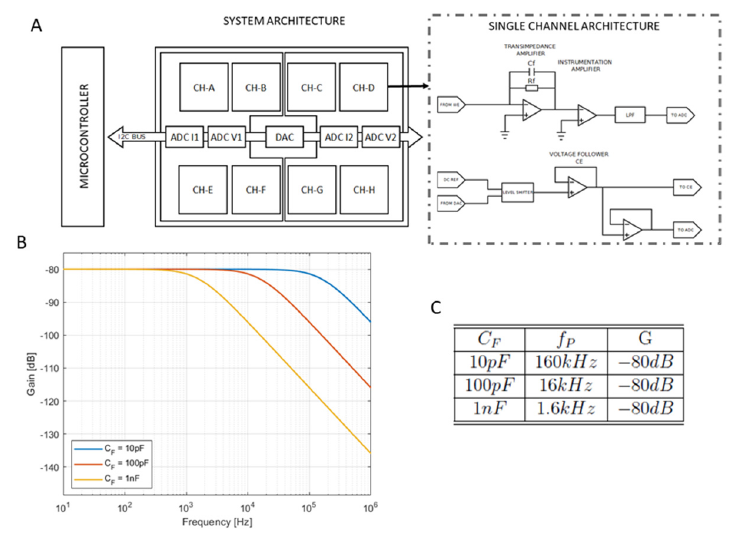
Figure 2. ( A ) Architecture of the 8-channel readout electronics system and schematic of an individual channel. ( B ) Frequency response of the TIA for different capacitor values. ( C ) Summary of the cutoff frequency obtained for the three different capacitors.